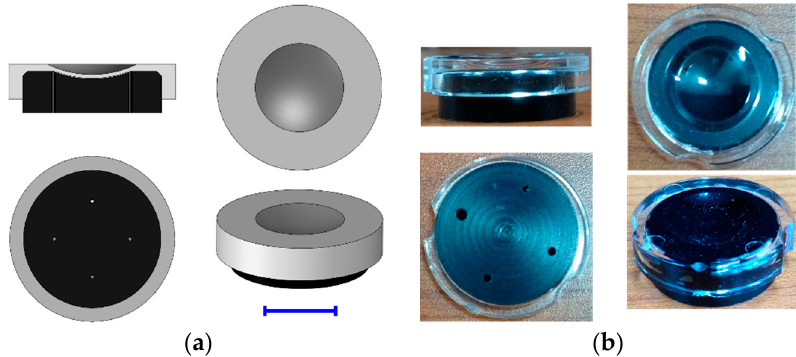
Figure 2. ( a ) 3D model of curved sample chamber composed of an upper window (gray color) and a lower substrate (black color). A sample solution is introduced into the gap of 100-µm thickness between those two separable parts through one of the holes in the lower substrate. The other three holes are air vents. (Scale bar = 10 mm). ( b ) Curved sample chamber fabricated by plastic injection molding technique. The upper window is optically clear for image acquisition and the lower substrate is colored black to minimize light reflection at the surface.